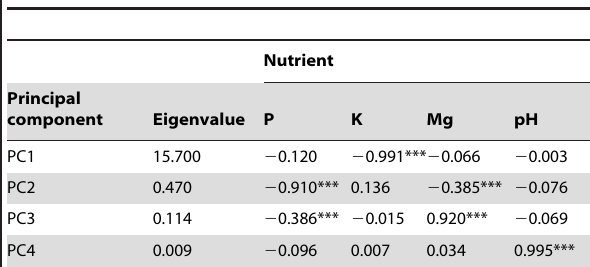
Table 1. Eigenvalues for the first four principal components (PC1-4) from a principal component analysis (PCA) on soil nutrients and pH and the Pearson correlation coefficient (r) between soil parameters and the four principal